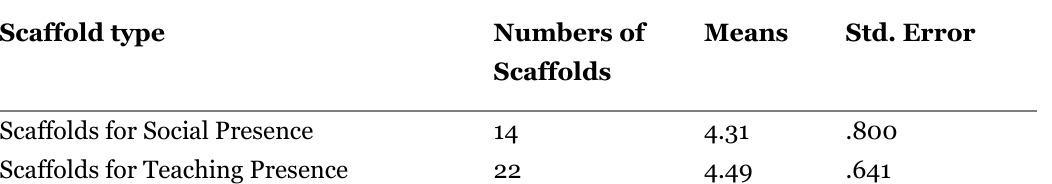
Survey Results on Effectiveness of Scaffolds for SP, TP, and CP